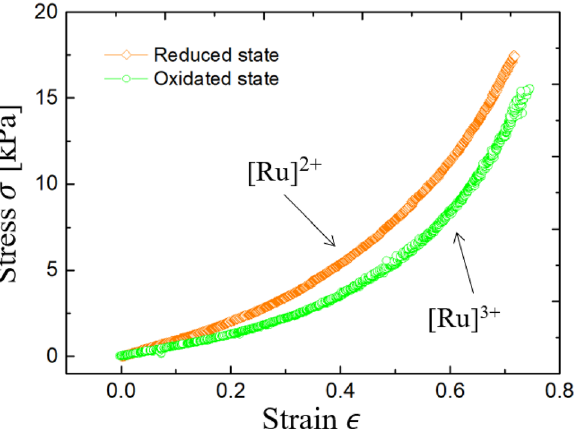
Figure 1. Stress–strain curves of the BZ gel. Orange and green represent the [Ru] 2+ and [Ru] 3+ states,